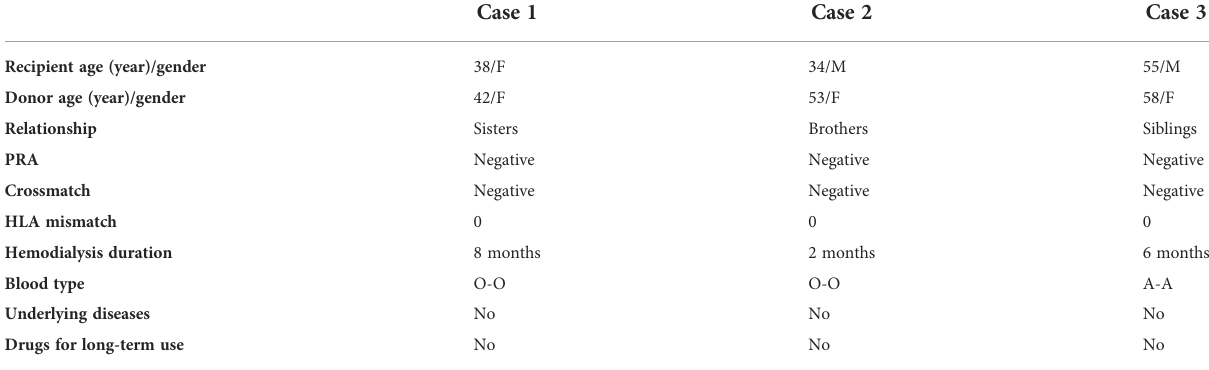
TABLE 2 Patients ’ baseline characteristics.